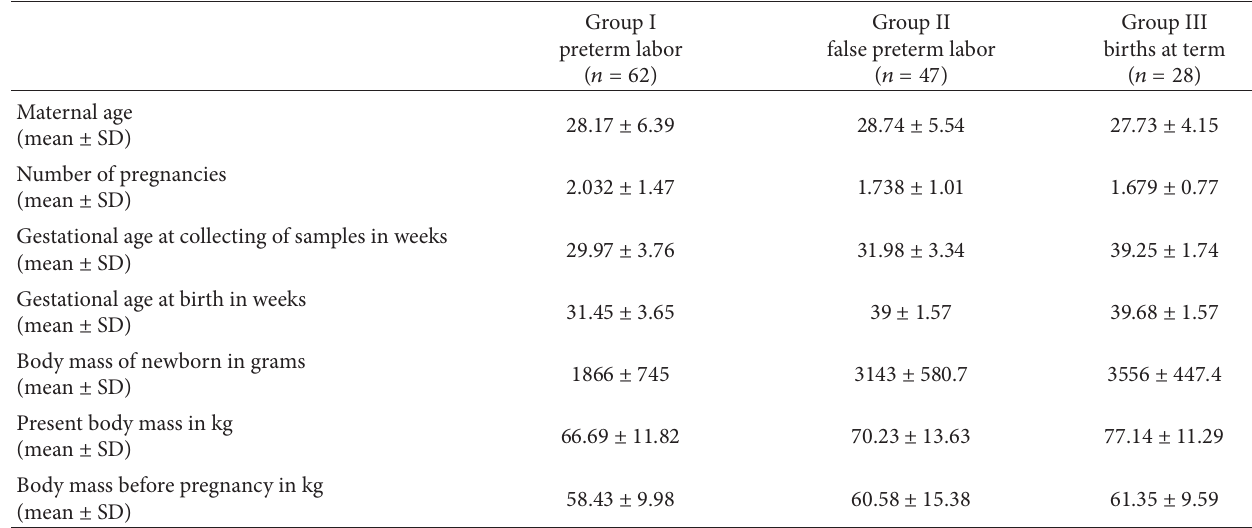
Table 1: Clinical characteristic of the